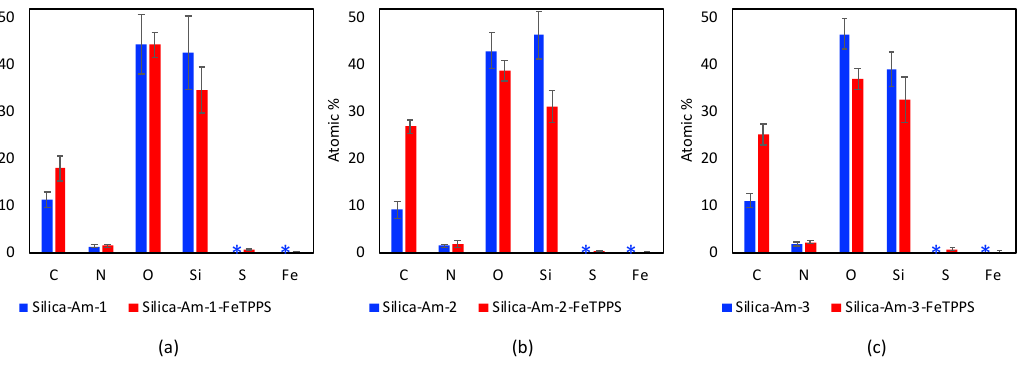
Figure 3. Elemental analysis of amino-functionalized silica particles (( a ) Silica-Am-1, ( b ) Silica-Am- 2 and ( c ) Silica-Am-3 marked with ∎